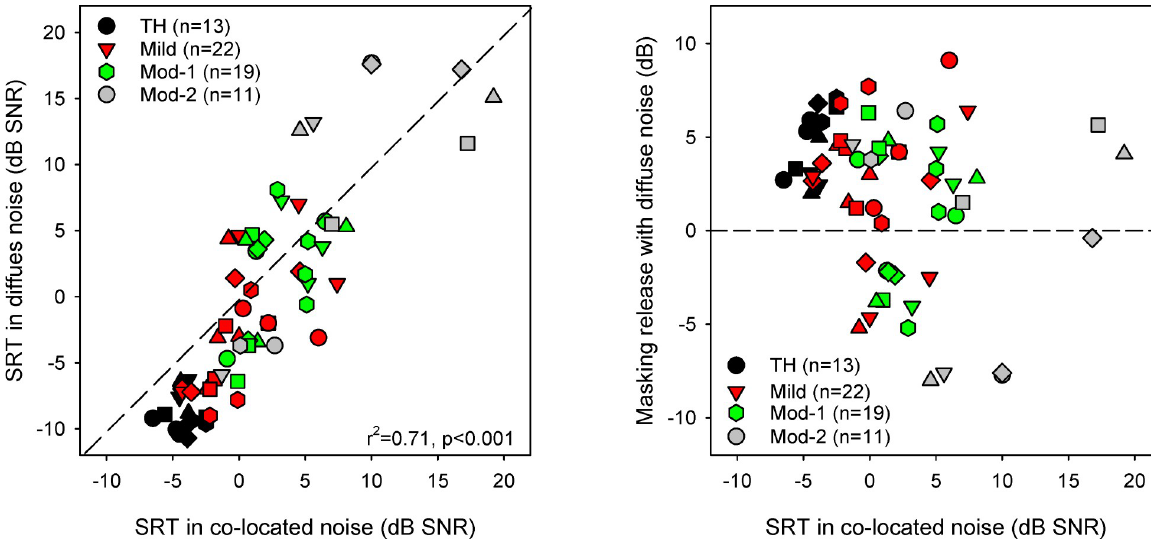
Fig 4. SRTs in diffuse vs. co-located noise. Left: SRTs in diffuse noise as a function of SRTs in co-located noise for the different hearing status groups. The solid diagonal line shows unity; values below the diagonal indicate that SRTs were lower with diffuse noise than with co-located noise. Right: Masking release with diffuse noise (SRTs in co-located noise—SRTs in diffuse noise) as a function of SRTs in co-located noise for the different hearing status groups. Values greater than 0 indicate masking release with diffuse noise; values less than 0 indicate interference with diffuse